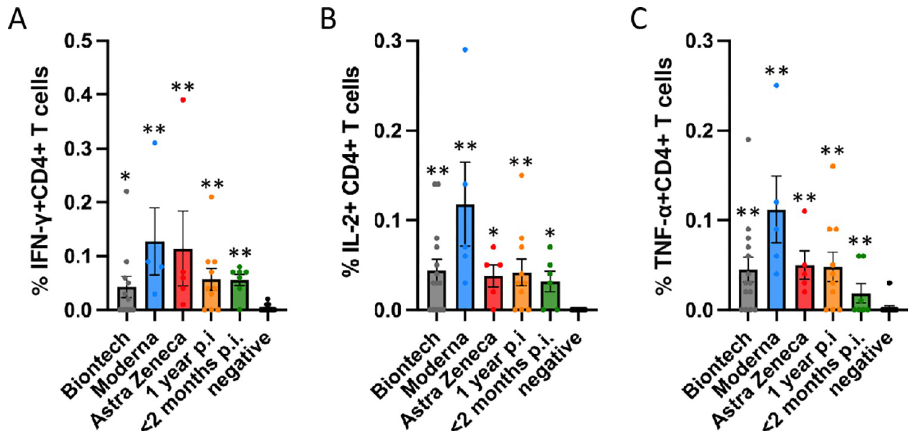
Fig 3. Antigen-specific CD4+ T cell responses to the Miltenyi peptide S protein pool. Antigen-specific CD4+ T cell responses elicited by the Miltenyi wt S protein peptide pool after vaccination with BioNtech (grey), Moderna (blue) or AstraZeneca (red), or one year (orange) or < 2 months (dark green) after naturally occurring infection with SARS-CoV2. In comparison, samples of healthy control subjects, who tested negative for SARS-CoV2-antibodies, are shown on the right of each panel. The bar graphs show frequencies of (A) interferon- γ (IFN- γ ), (B) interleukin-2 (IL- 2)- and (C) tumor necrosis factor- α (TNF- α )-positive CD4+ T cells. The figure shows results of n = 13 independent individuals after vaccination with BioNtech, n = 5 Moderna, n = 5 AstraZeneca, and n = 10 independent individuals one year and n = 7 subjects < 2 months after natural infection with standard errors of the mean (SEM). For comparison, 13 negative healthy controls were included. Significance levels were tested by Kruskal-Wallis test for non- parametric values. � p < 0.05, �� p < 0.01 vs. healthy controls.